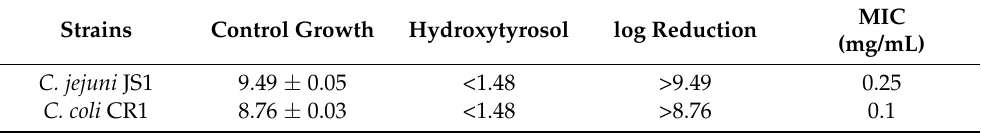
Table 4. Antibacterial activity and minimal inhibitory concentration (MIC) of hydroxytyrosol (2 mg/mL) against C. jejuni JS1 and C. coli CR1 strains. The results are expressed in log CFU/mL ± standard deviation (SD) ( n = 3).